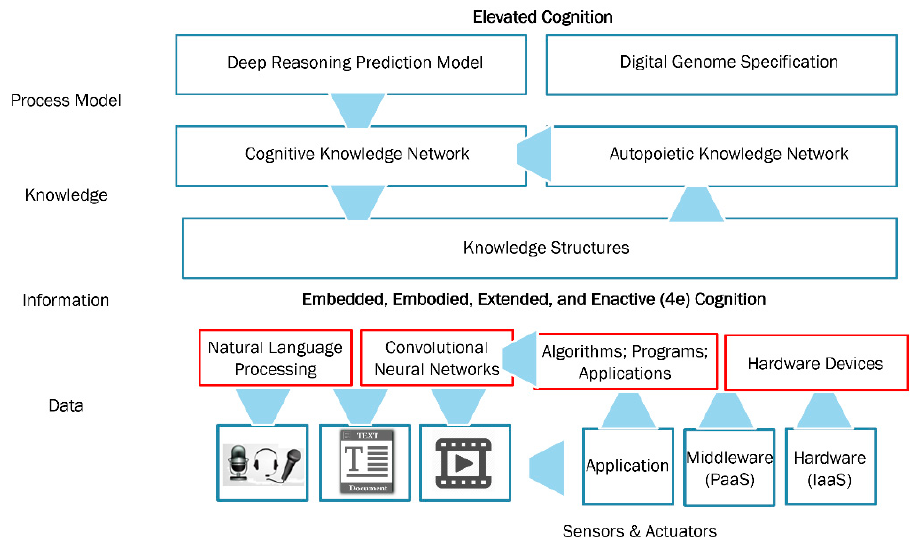
Figure 5. Super-symbolic computing structure with a common knowledge representation using knowledge structures and structural knowledge structures and structural machines.